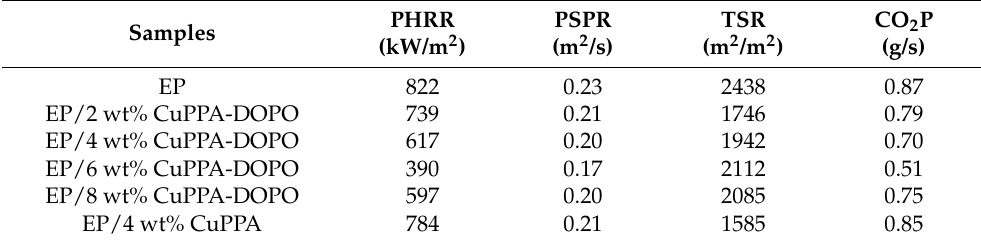
Figure 5. ( a ) HRR, ( b ) SPR, ( c ) TSR and ( d ) CO 2 P curves of pure EP and EP composites. Table 3. CCT data of pure EP and EP composites.